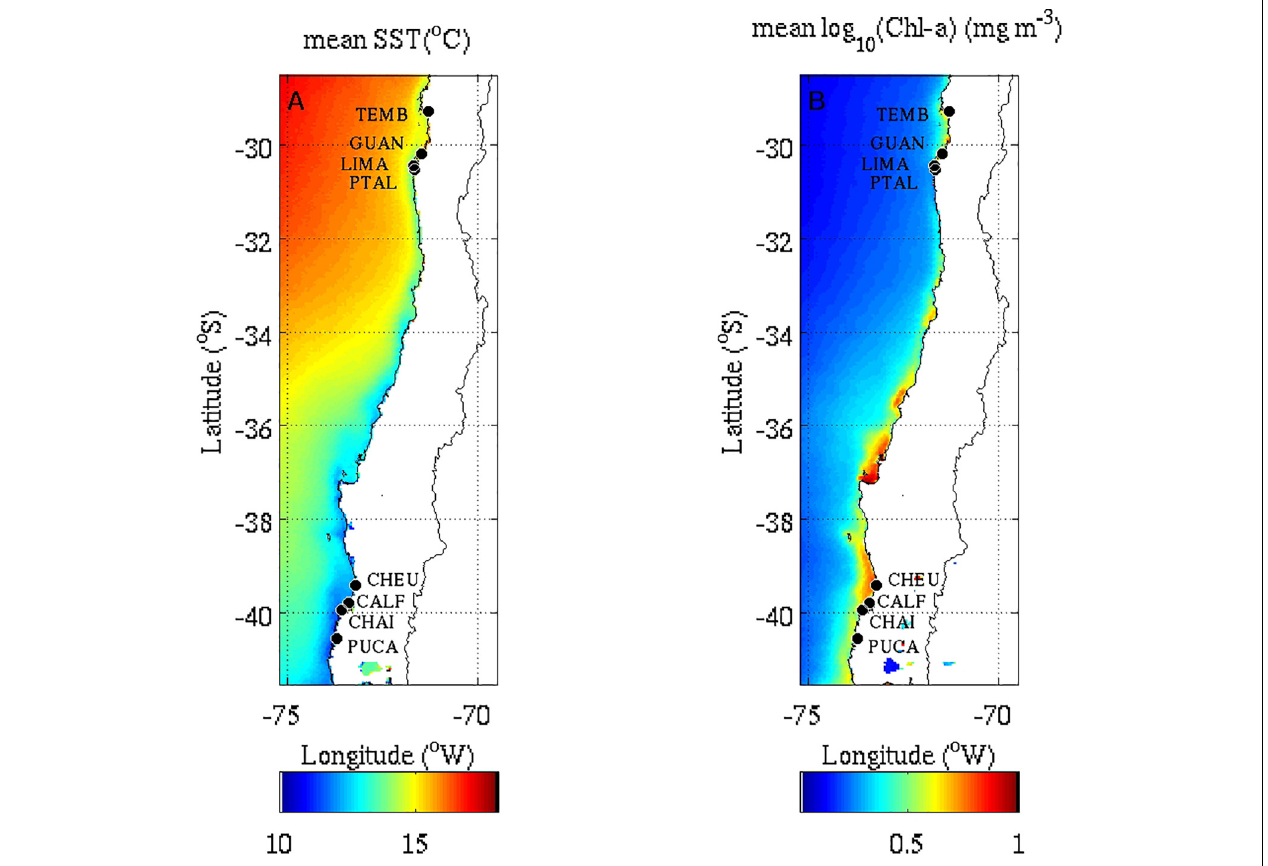
FIGURE 1 | Location of study sites in the northern and southern regions in the SE Pacific shore of Chile. Color scales denote long-term temporal mean (2003–2018) of (A) sea surface temperature and (B) log 10 Chlorophyll- a concentration using L3 MODIS-aqua data (Lara et al., 2019). Site codes are in Table 1 . Mazzaella -dominated communities: LIMA and PTAL; barnacle-dominated communities: TEMB, GUAN, and CHAI: Perumytilus- dominated communities: CHEU, CALF, and PUCA. Sea surface temperature and Chlorophyll-a data were not included in the statistical analyses and are shown here to describe the environmental conditions across the province. TABLE 1 | Identity of the dominant species experimentally removed at each rocky shore site in each region. Region Lat. Lon. Site Site code Mazzella Barnacles Perumytilus λ